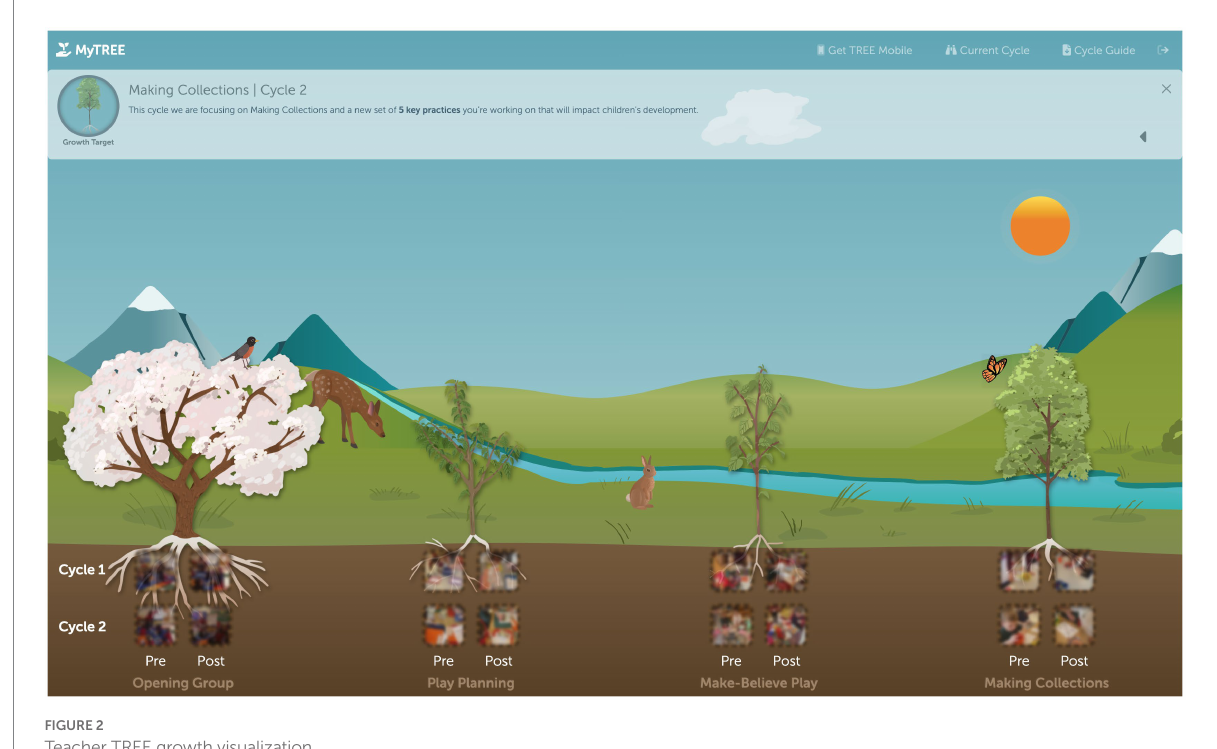
FIGURE 2 Teacher TREE growth visualization.